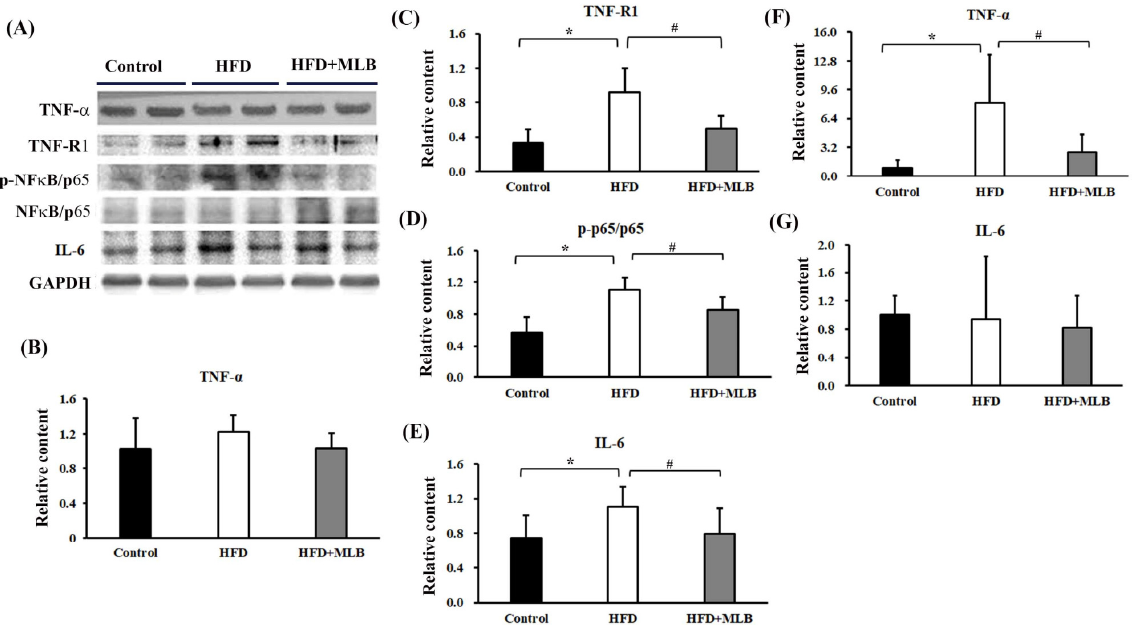
Figure 7. MLB supplementation attenuated HFD-induced muscle atrophy through the downregulation of TNF-α/NF-κB signaling. Proteins were isolated from the skeletal muscles and subjected to a Western blot with antibodies against TNF-α, TNFRI, NF-κB/p65, p-NF-κB/p65, IL-6, and GAPDH. Two representative samples from each group are presented ( A ), and the quantitative data are depicted ( B – E ). Total RNAs were extracted from epididymal adipose tissues and subjected to RT-qPCR for the measurement of TNF- α ( F ) and IL-6 ( G ) mRNA levels. Values are expressed as mean ± SD. * p < 0.05 vs. control group. # p < 0.05 vs. HFD group. n =